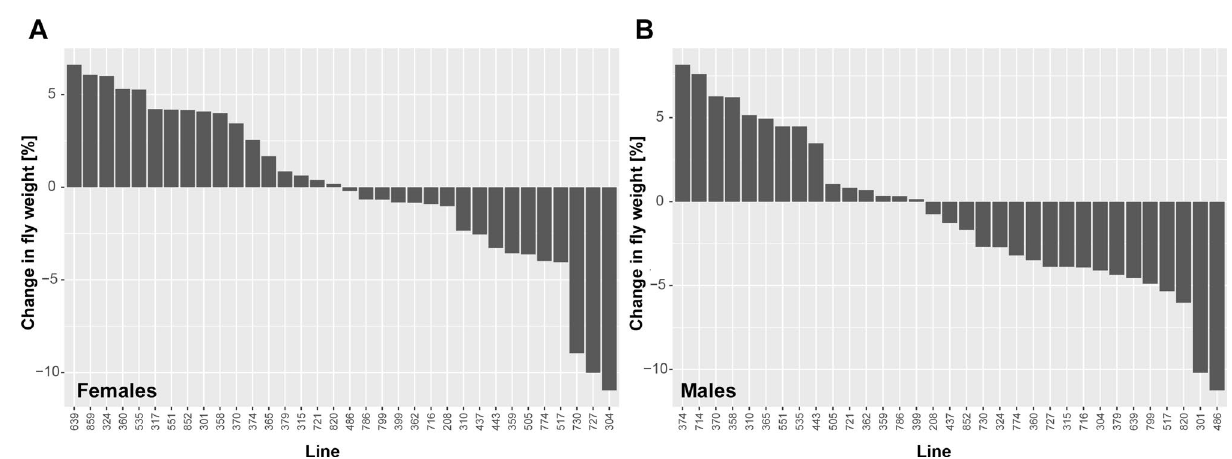
Figure 7. Weight gains as well as losses are seen after exercise treatment. X-axis—DGRP line number; Y-axis— weight change relative to control in % calculated as (control-treatment)/control*100. ( A ) Data from females. ( B ) Data from